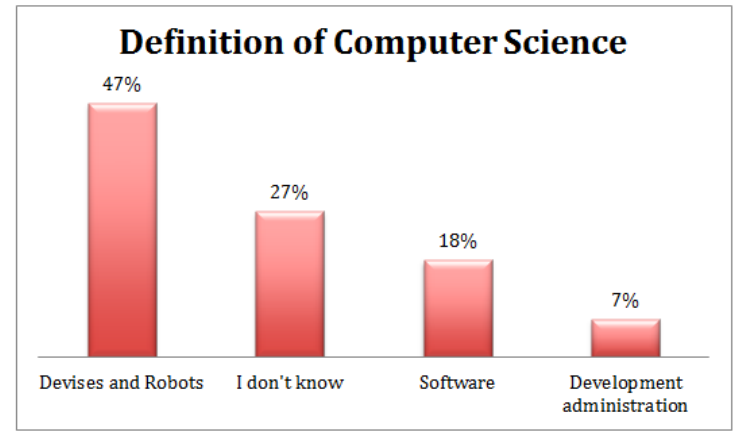
Figure 6. Definition of CS in percentage of related